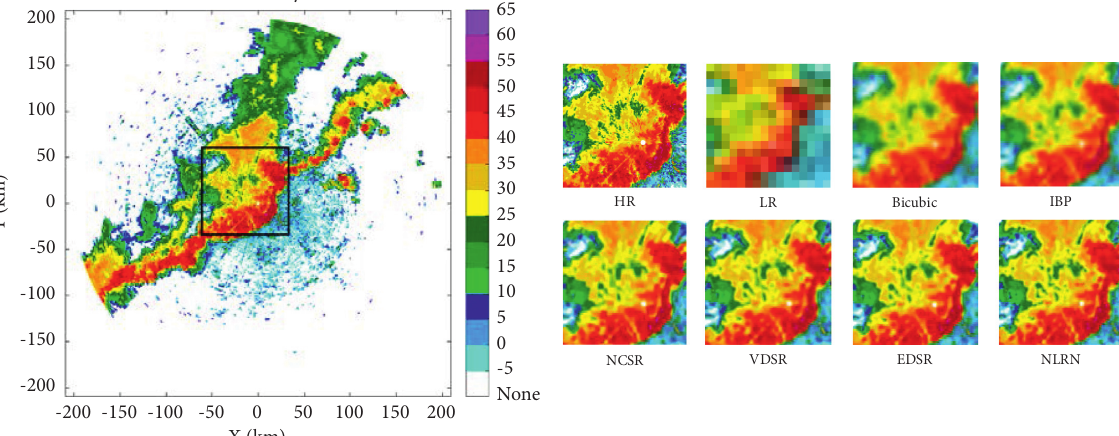
Figure 8: Visual comparison of × 4 super-resolution reconstruction results of intense precipitation data. The best results are in